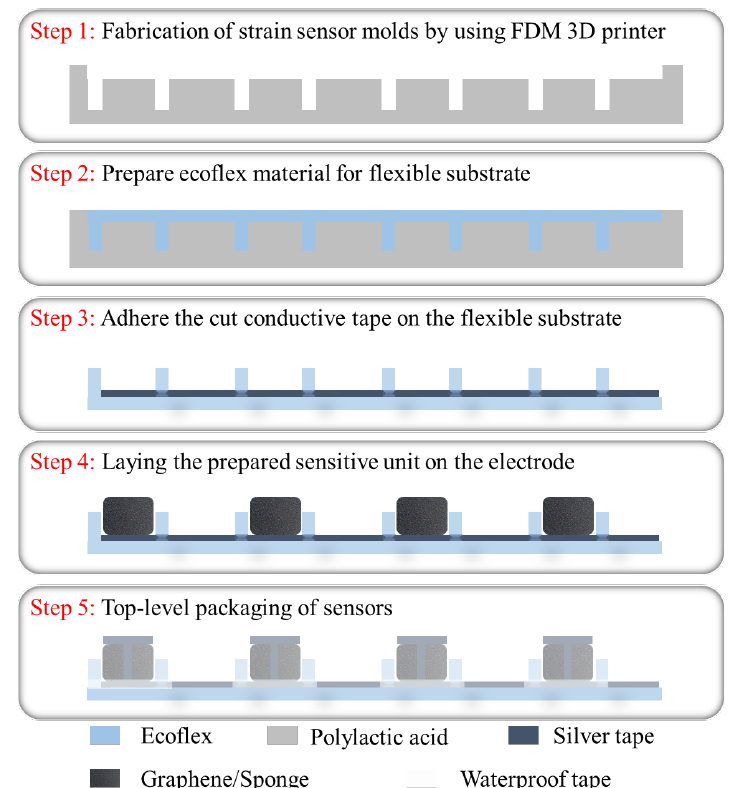
Figure 3. The fabrication process of the flexible sensing array.